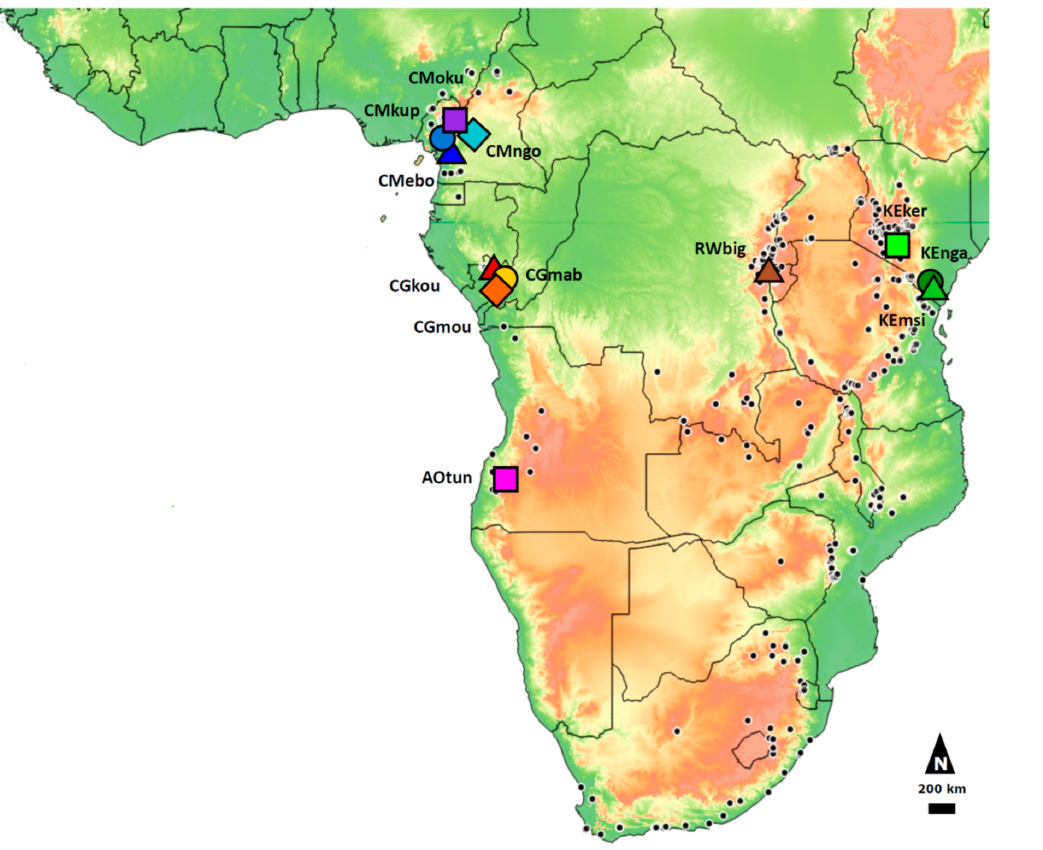
Figure 1. Populations of Podocarpus latifolius sampled for genetic analyses in Angola (AO), Cameroon (CM), Republic of the Congo (CG), Kenya (KE), and Rwanda (RW). Symbols and colors correspond to the DAPC analyses. Black dots refer to the distribution range of P. latifolius (data extracted from GBIF, field missions, herbarium specimens (BRLU, BR, P), the Conifers of the world database, see [16]). Colors on the map refer to elevation, using the software QGIS (QGIS.org, 2021. QGIS Geographic Information System. QGIS Association (http://www.qgis.org, accessed on 25 January